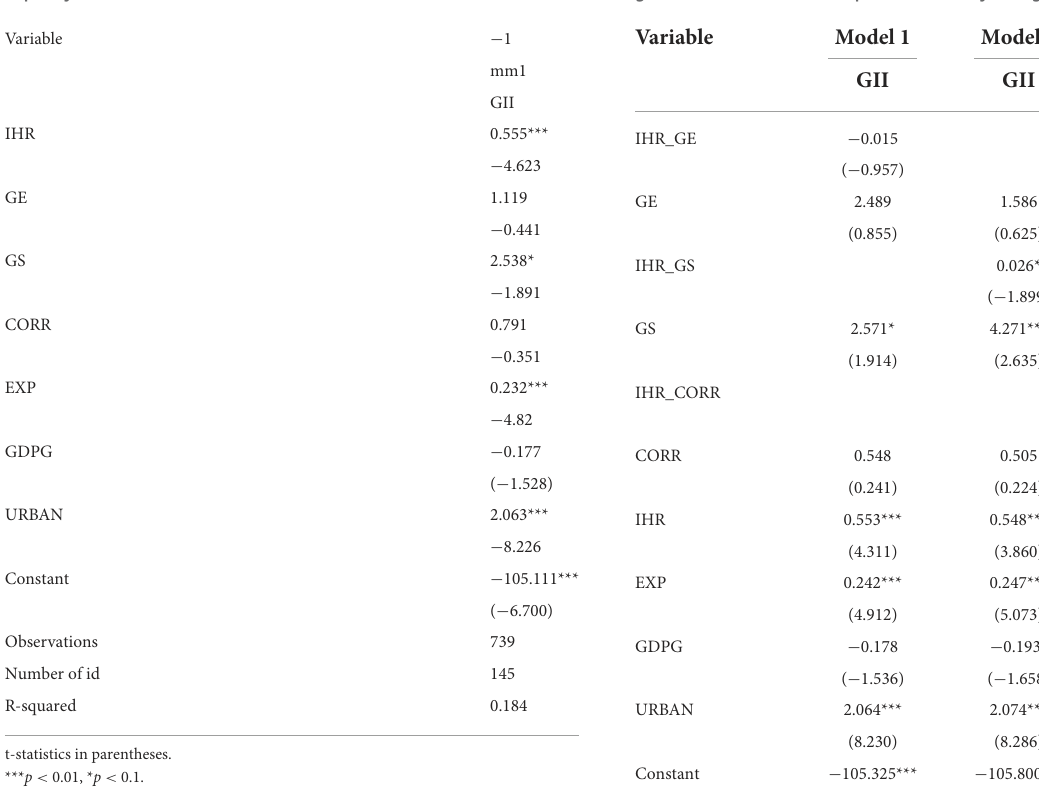
TABLE 5 Interaction effects between public health policy quality and government effectiveness, political stability, and government